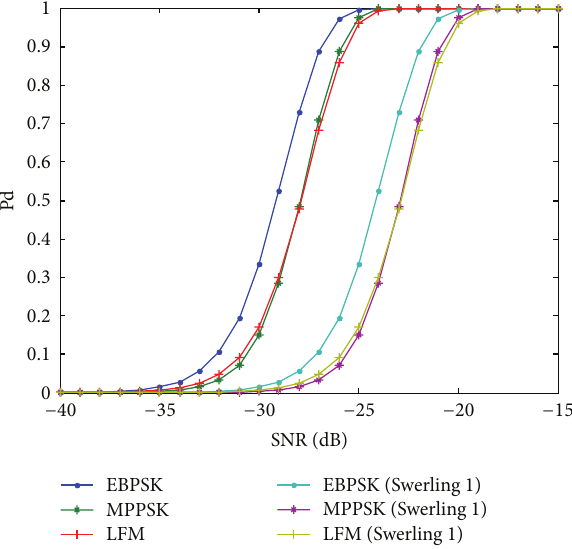
Figure 4: CFAR target detection probability comparisons for V = 400